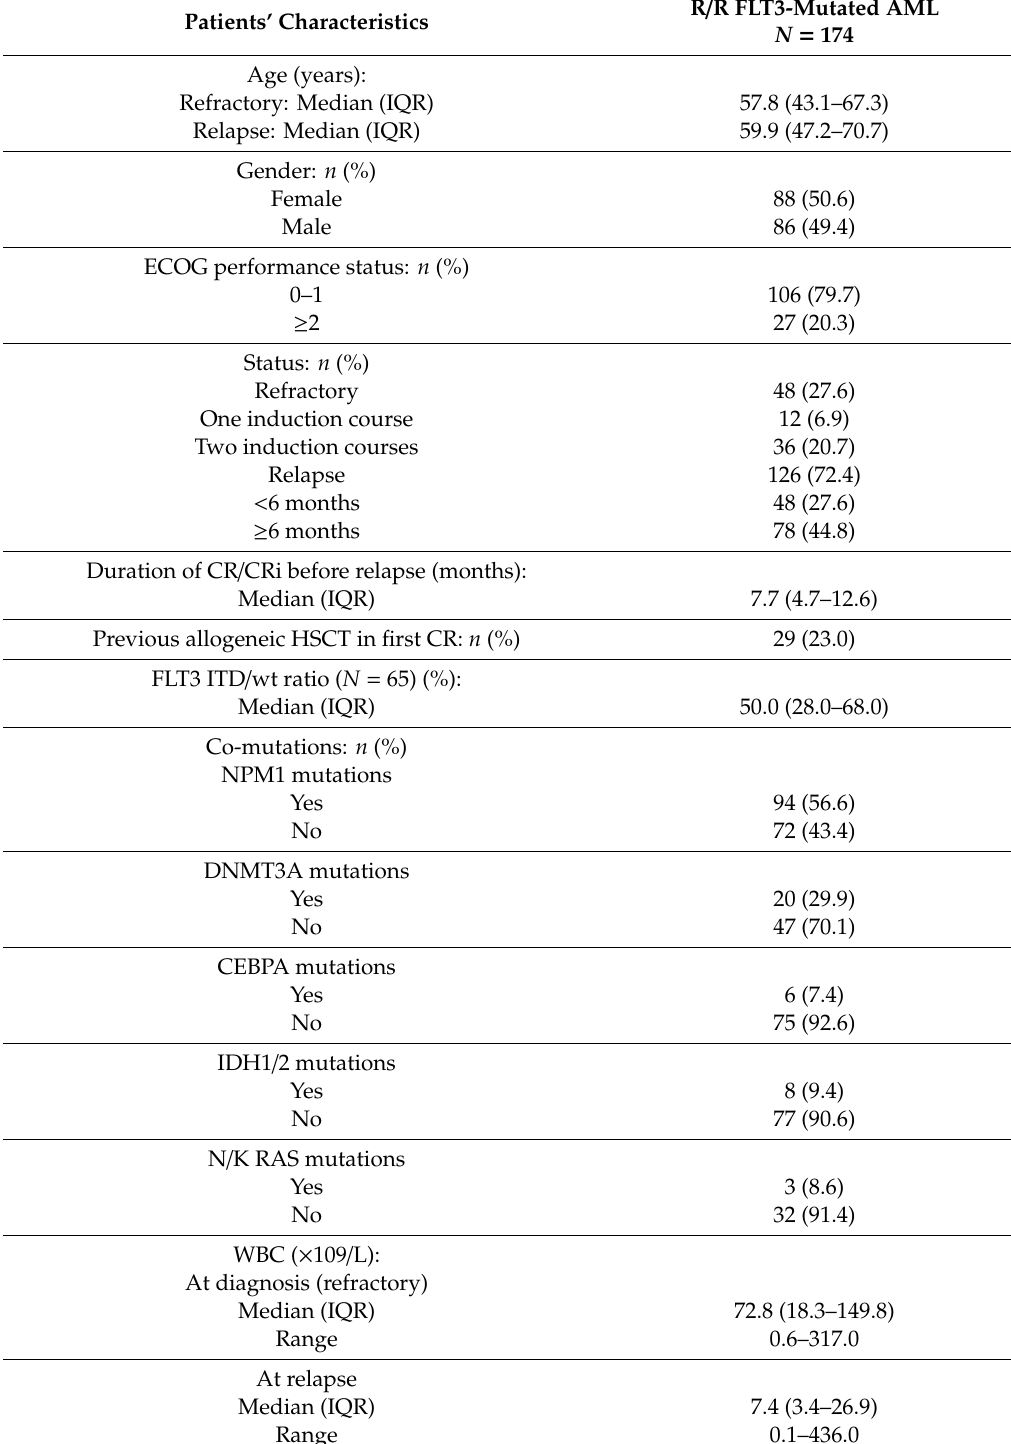
Table 3. Characteristics of patients with relapsed / refractory FLT3 -mutated acute myeloid leukemia ( n =